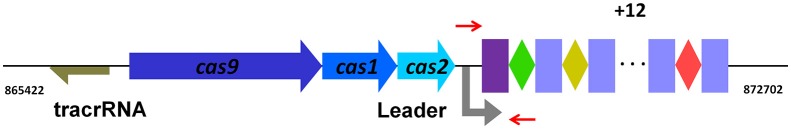
Organization of the type II-C CRISPR-Cas system from RA-CH-2. The CRISPR1 locus from RA-CH-2 comprises three cas genes (cas9, cas1, and cas2), 16 repeats (purple or blue rectangles, 47 bp long) and 15 spacers (colored diamonds, 30 bp long). The tracrRNA (trans-activating crRNA, brown arrow) containing the region with complementarity to the repeats is located upstream of cas9. Between cas2 and the first repeat (purple rectangle), the A/T-rich region is the presumed leader sequence. The primers (short red arrows) were used for PCR amplification to detect CRISPR1 expansion.